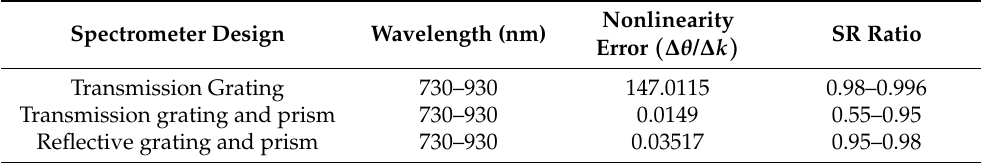
Table 1. Summary of the designed